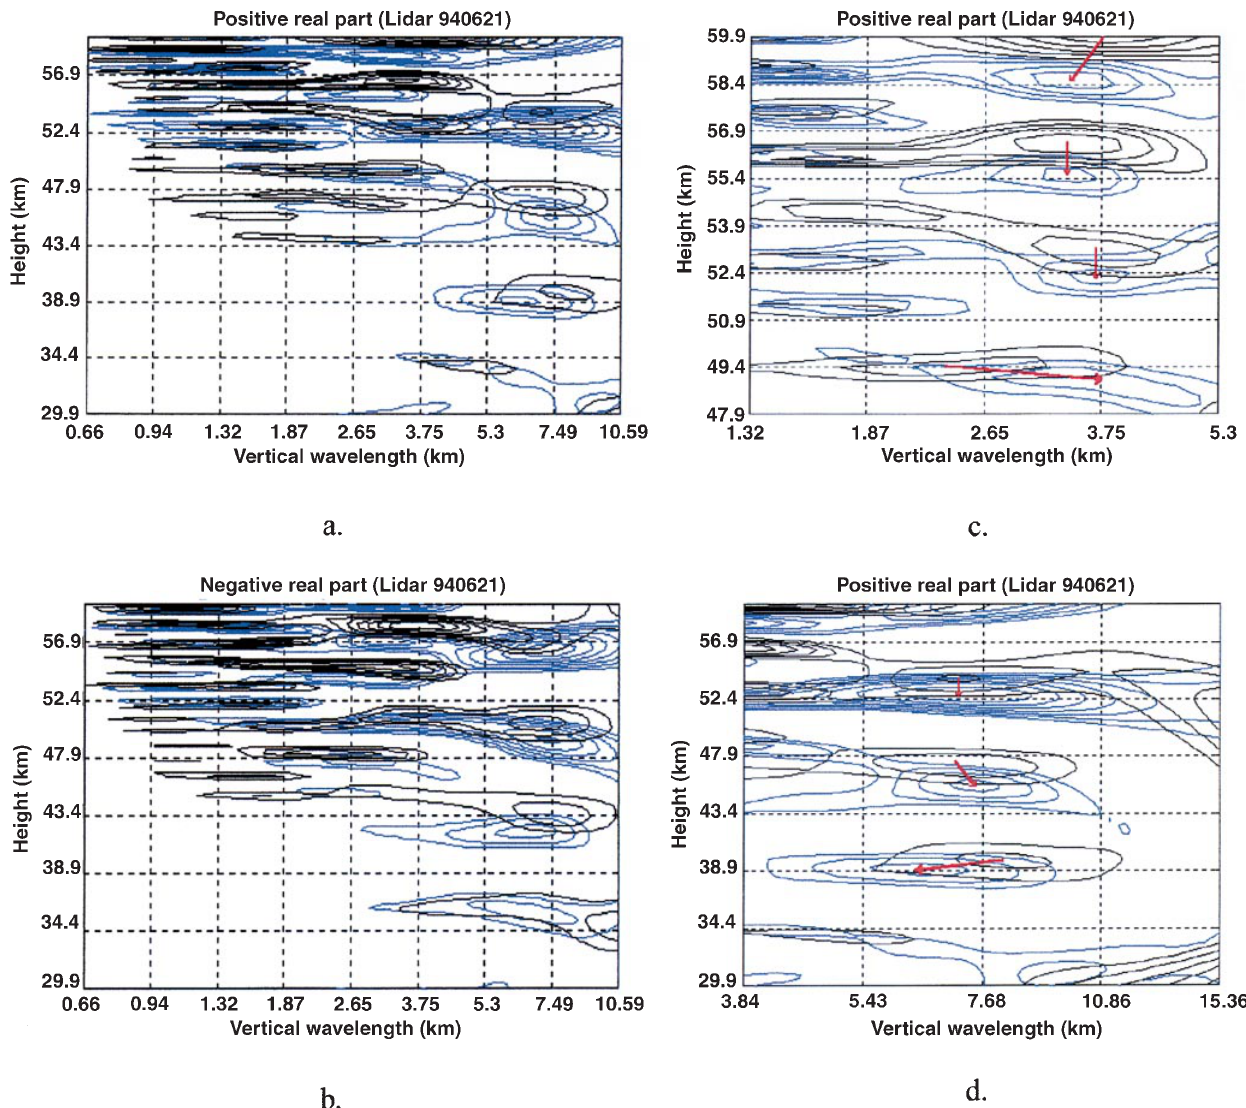
observed waves. c, d show zoom-ins for the dominant modes with 3-km and 7-km vertical wavelengths, respectively. The direction of the arrows indicates a downward